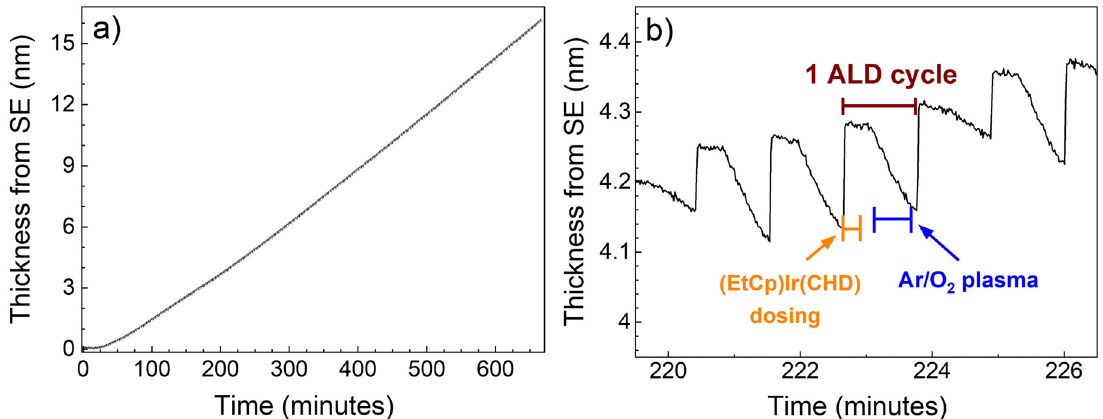
Figure 1. ( a ) Time-resolved in situ spectroscopic ellipsometry measurements during 600 ALD cycles of IrO 2 , at 150 °C onto PtSi. The process exhibits linear growth after a nucleation period of about 50 cycles, corresponding to about 55 min on the time scale. ( b ) Enlargement of the in situ measurement reported in ( a ), showing the characteristic step-like behavior found for the ALD process, with a thickness increase due to the precursor dosing and a subsequent thickness decrease during the plasma dosing due to the removal of ligands.